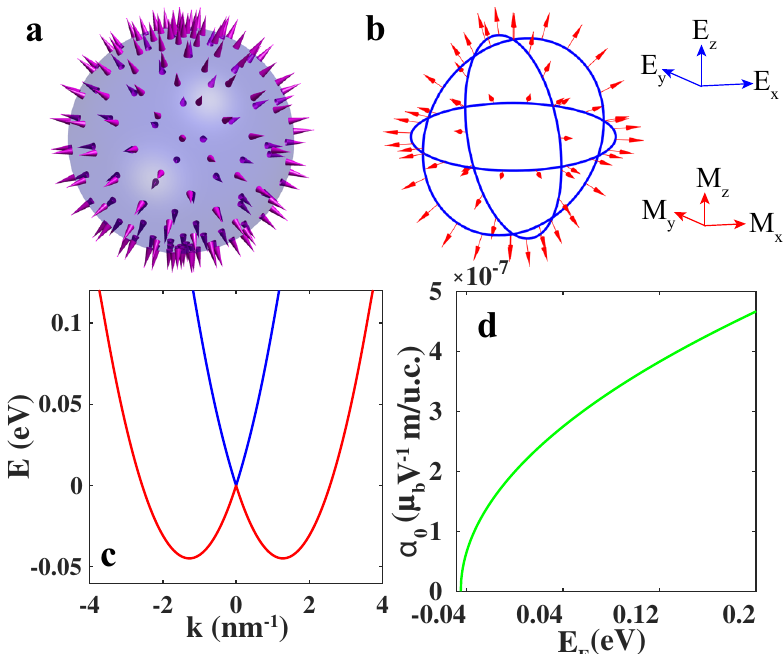
Fig. 1 The longitudinal magnetoelectric response of isotropic Kramers Weyl semimetals. a The Weyl spin texture of isotropic Weyl spin-orbit coupling ℏ v k ⋅ σ at the Fermi surface from the band branch + . b The electrically induced magnetization is parallel to the applied electric fi eld. Here blue and red coordinates are the Cartesian coordinates for the applied electric fi eld E ¼ E x ; E y ; E z dispersion for the isotropic chiral Weyl semimetal. The blue and red line corresponds to the + and − band branch respectively. d The magnetoelectric susceptibility α 0 strength as a function of the Fermi energy E F . In the presence of external electric fi eld, α 0 gives the number of Bohr magneton μ cell (u.c.) to denote the magnetization in the material.